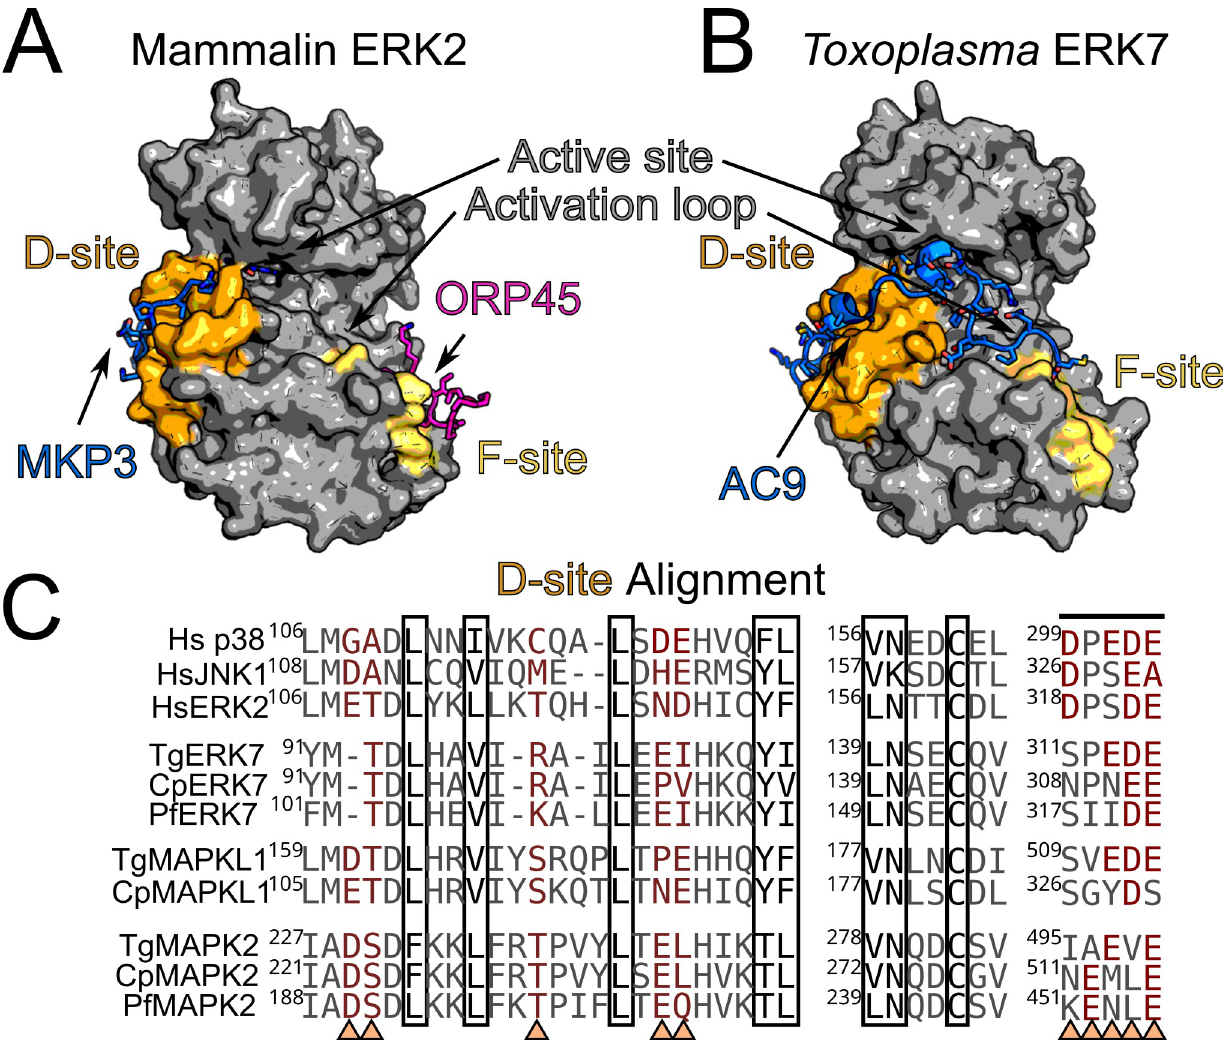
Fig 3. MAPKs use docking sites to recognize substrates and regulators. (A) Canonical MAPKs use the conserved D-site (orange) to recognize kinase- interaction-motifs such as that of MKP3 bound to ERK2 (blue; PDB: 2FYS). This site lies distal to the active site and substrate recognition region. Some MAPKs use a second docking site, the F-site (yellow) to recognize F-x-F-P motifs such as that found in ORP45 (purple; PDB: 7OPM). (B) The inhibitory scaffold AC9 wraps around the Toxoplasma ERK7 kinase domain (blue; PDB: 6V6A) and occupies both the D-site (orange), active site, and substrate- recognition region. The site where the F-site would be localized on the TgERK7 structure is indicated in yellow, though no F-site binding partners have yet been identified for an apicomplexan MAPK. It is possible that apicomplexan MAPKs do not use F-site recognition. (C) Alignment of the sequences comprising the D-site of the indicated MAPKs. Polar (mostly acidic) sites that are thought to provide specificity to the KIMs recognized are indicated by arrowheads and red text. Sites that typically make backbone or hydrophobic interactions with KIMs are boxed. (Hs–human; Tg– T . gondii ; Cp– C . parvum ; Pf– P . falciparum ) KIM, kinase-interacting motif; MAPK, mitogen-activated protein